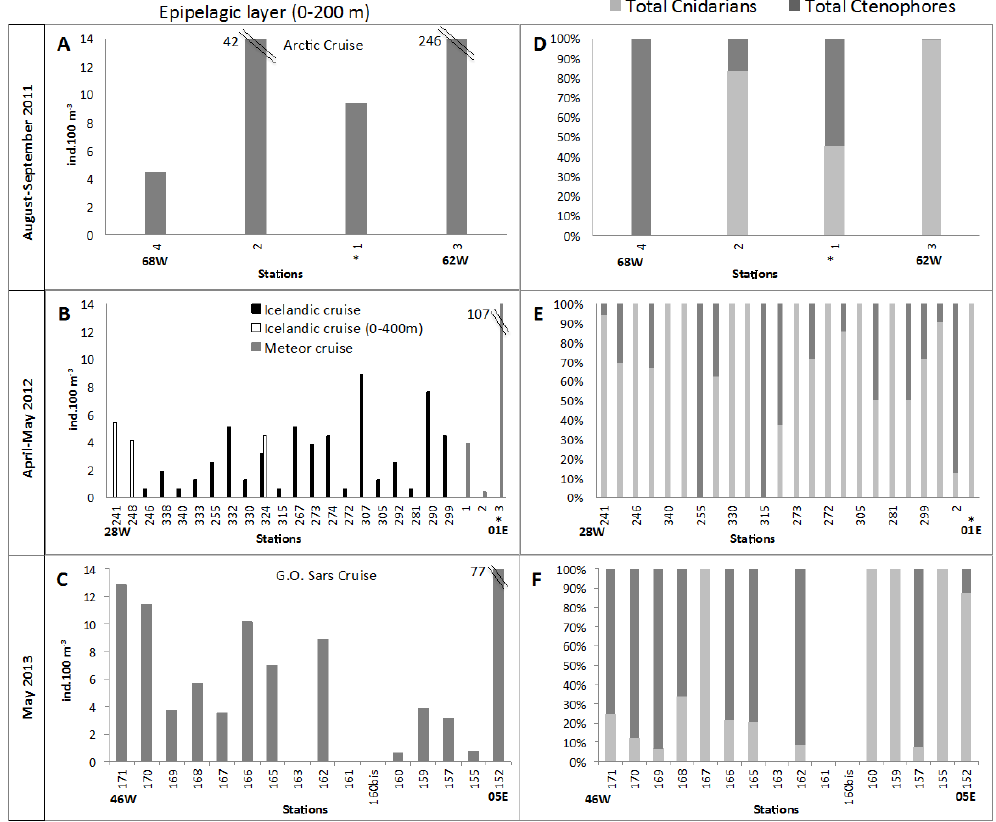
Figure 2. Total jellyfish abundance and relative proportion of Cnidaria and Ctenophora in the stations sampled during the Arctic cruise ( a and d ), the Icelandic and Meteor cruise ( b and e ) and the G.O. Sars cruise ( c and f ).